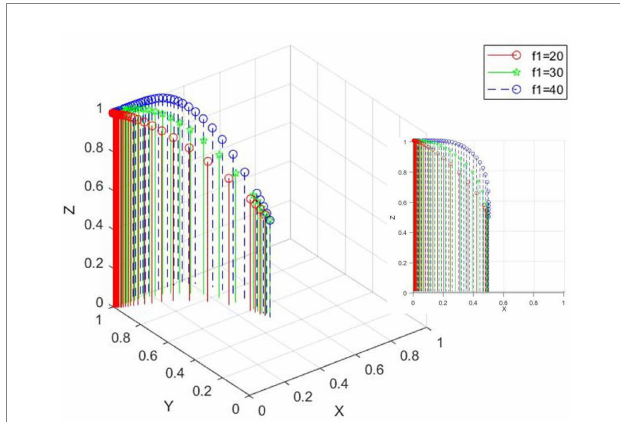
FIGURE 10 The impact of the government on the amount of fines imposed by third-party testing agencies (Scenario 2).